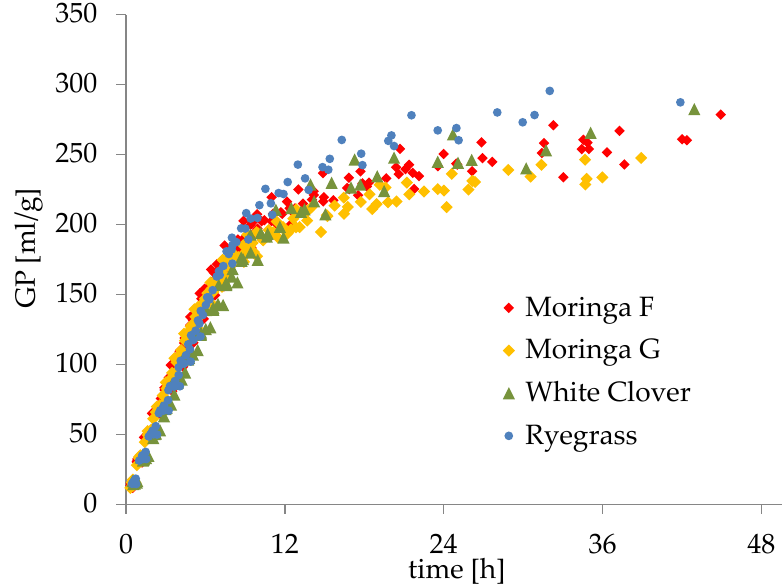
Figure 2. Real-time production of gas production (mL/g) for M . oleifera in field (Moringa F) and in greenhouse (Moringa G), ryegrass and white clover. Table 3. Total gas production, methane and proportion of methane at 12 and 24 h for perennial ryegrass ( L . perenne ), white clover ( T . repens ) and M . oleifera. The average standard error of the dif- ferences of means (SED) and p -value are presented. GP t 1/2 max(h) and CH4 t 1/2 max(h) (half for M . oleifera in open field and greenhouse are the average for F1, F2, F3 and G1, G2, G3 respectively. t 1/2 max signifies half the maximum time.